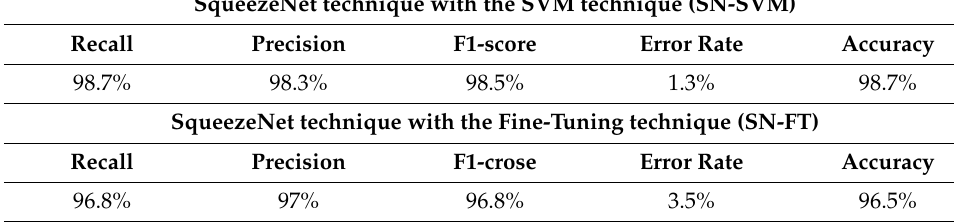
Figure 11. Results performance of the SN-SVM and SN-FT methods. Table 4. Results of the performance of the SN-SVM and SN-FT methods.